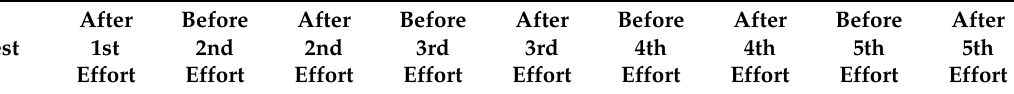
Table 5. Differences in blood lactate levels obtained between measurements, separately for tempera- tures of 21 ◦ C and 31 ◦ C (ANOVA, planned